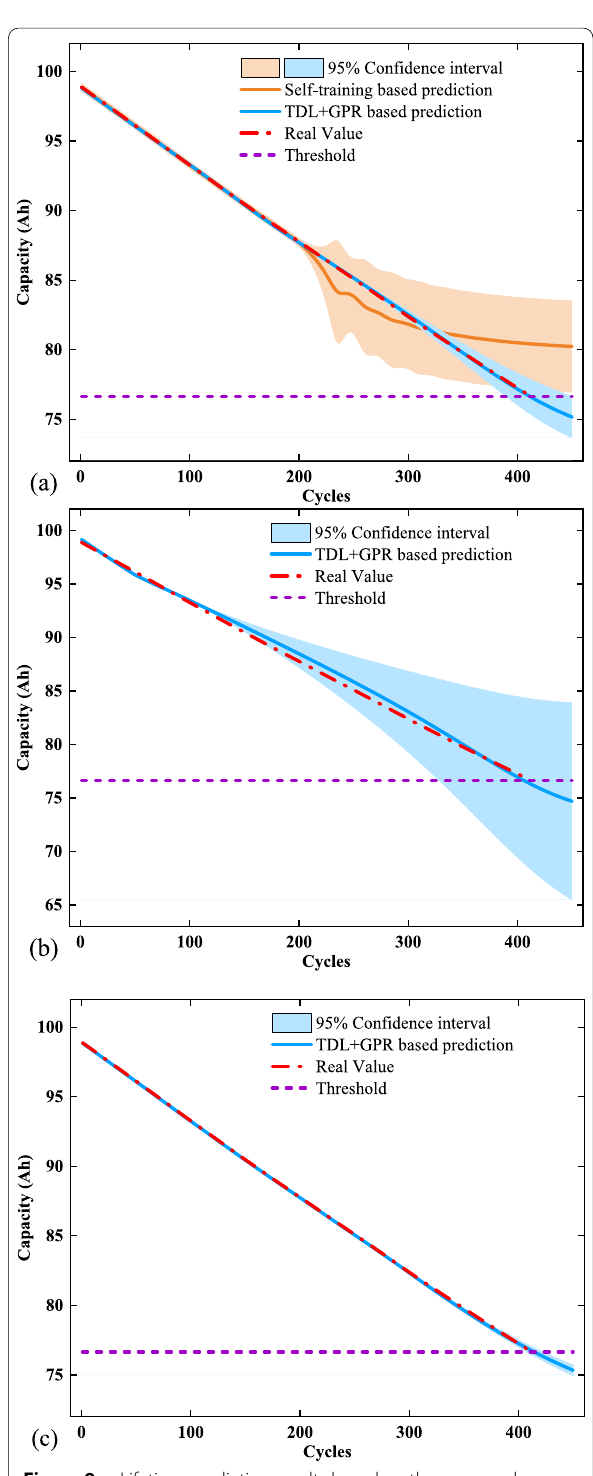
Figure 9 a Lifetime prediction results based on the proposed method and conventional method when the data of first 200 cycles is available; lifetime prediction results with data of the first, b 100/ c 300 cycles is used for